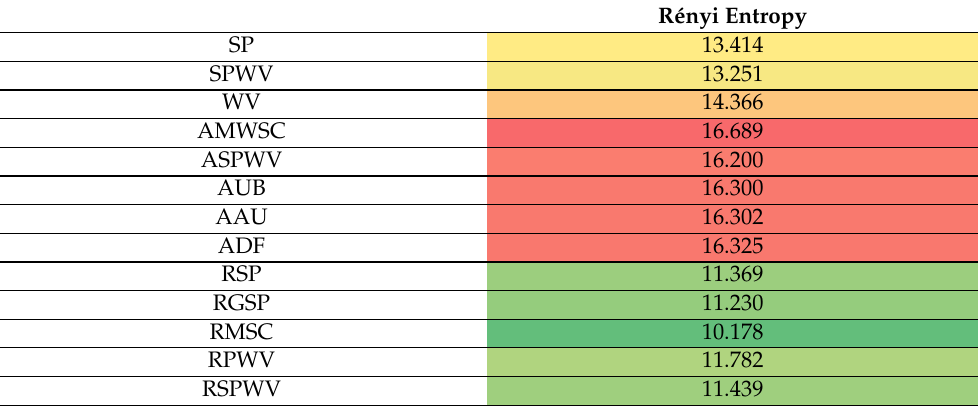
Table 9. TFR Rényi entropy of an EEG P300 signal for the Cz electrode (averaged over 466 trials), cell colors range from green for the best result to red for the worst result in each column